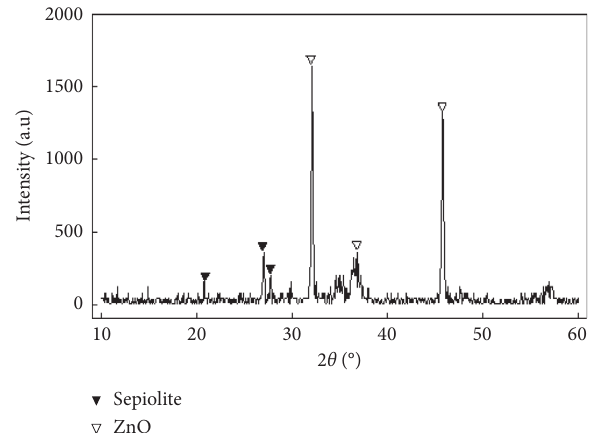
Figure 20: XRD pattern of ZnO.